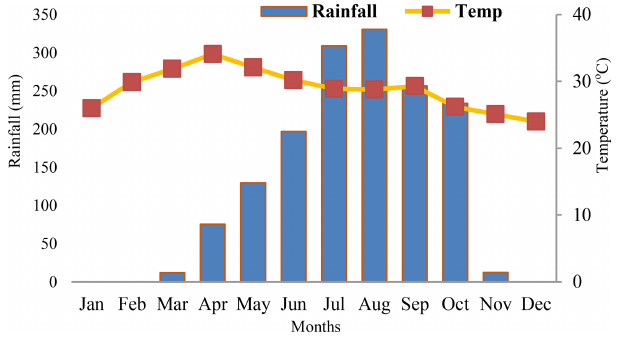
Figure 2. Mean monthly rainfall and temperature relationship for baseline scenario from 1988 to 2019 in GRC.